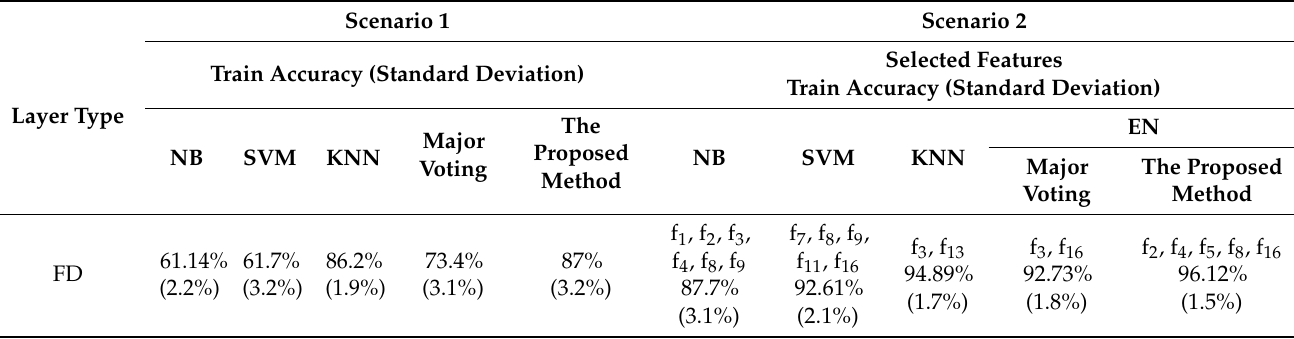
Table 6. The training results of the FD